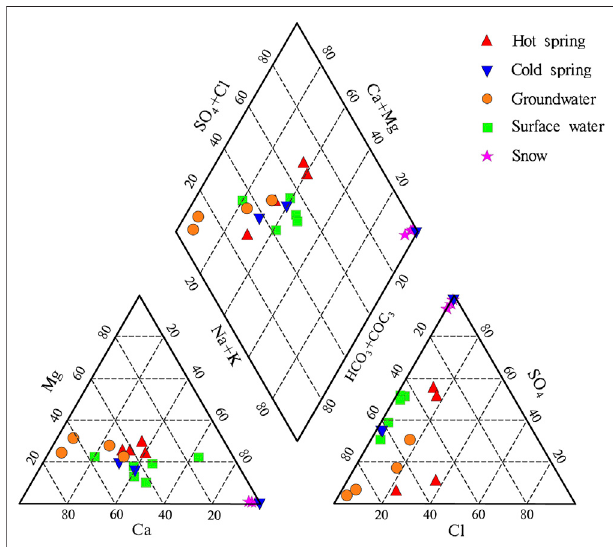
FIGURE 2 | Piper trilinear diagram of the water samples from the Jiangcang